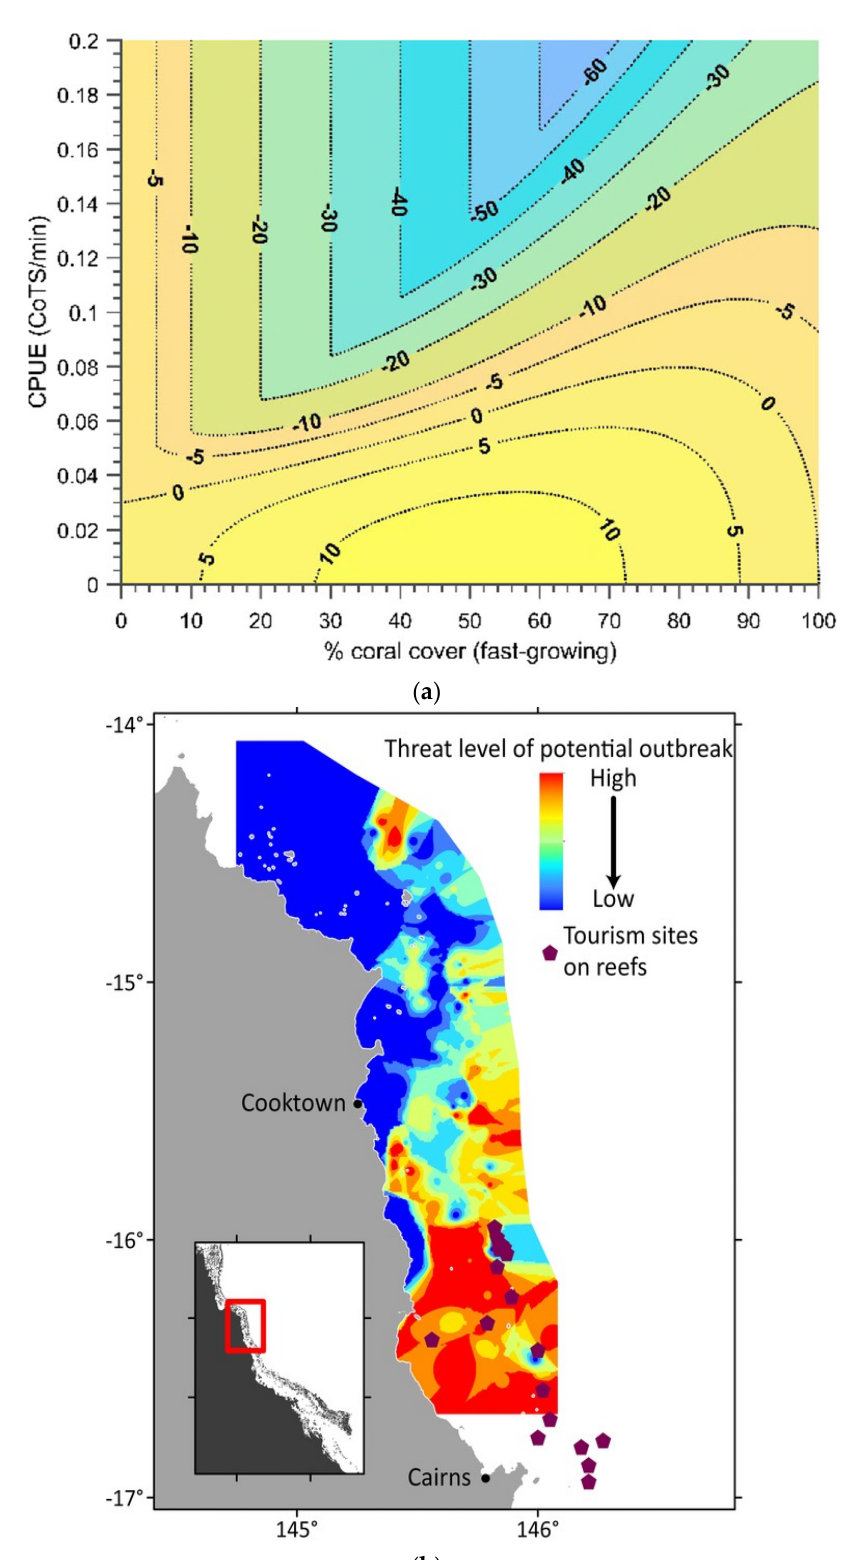
Figure 10. ( a ) Steady state coral cover values (shaded area) under varying scenarios of coral cover and COTS density as measured by CPUE (from Figure 6 in [76]); ( b ) Predicted importance of reefs on the GBR for seeding outbreaks on other reefs (from Figure 3 in [79]).